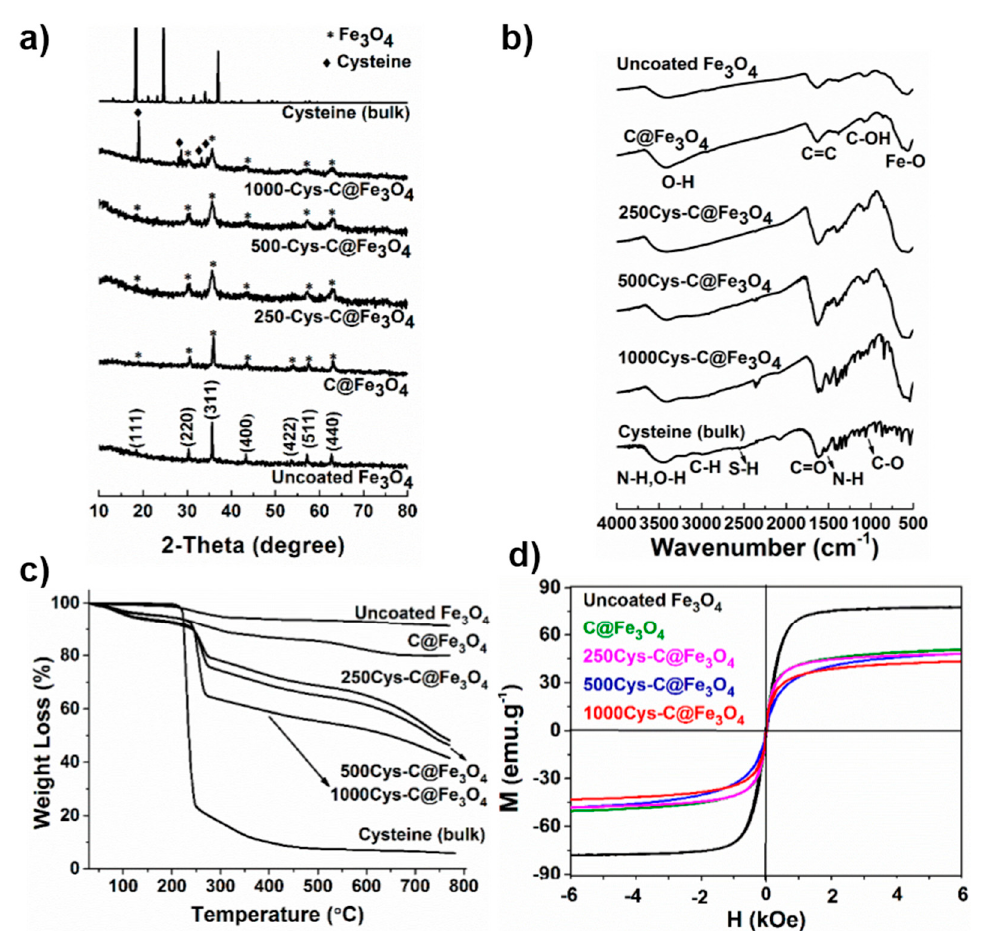
Figure 3. ( a ) Powder X-ray diffraction (PXRD) patterns, ( b ) FTIR spectra, ( c ) thermogravimetric (TG) curves, and ( d ) magnetic behavior of uncoated Fe 3 O 4 , C@ Fe 3 O 4 , and Cys - C@Fe 3 O 4 materials. The Y axis in ( a ) and ( b ) are given in arbitrary unit.